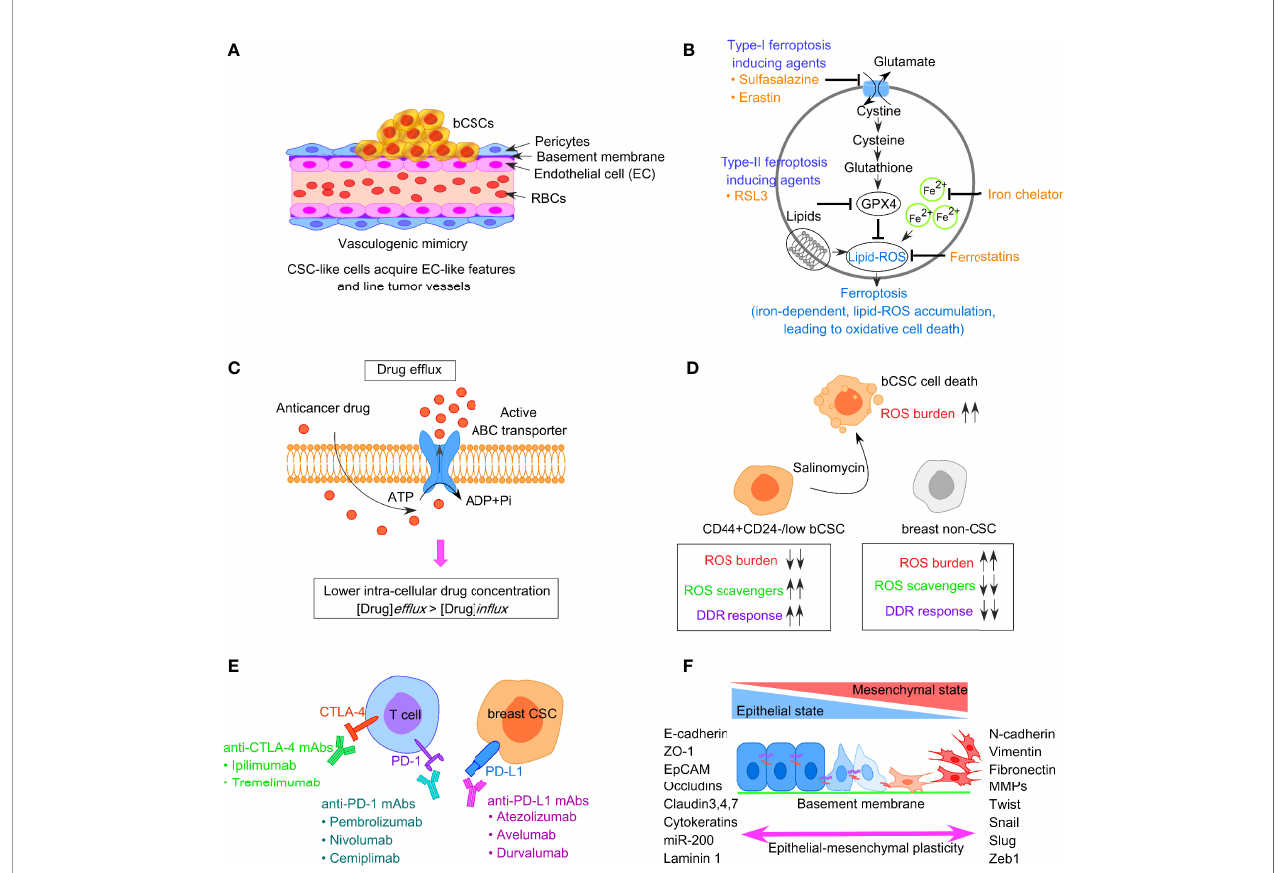
FIGURE 3 | Factors responsible for bCSC-mediated drug resistance against traditional anticancer therapeutics. (A) Concept of vasculogenic mimicry observed in breast CSCs leading to drug resistance. (B) Representative image of ferroptosis pathway involving generation of lipid-ROS in an iron-dependent manner, leading to oxidative cell death of tumor cells. (C) Increased drug ef fl ux due to enhanced expression of ABC transporters in bCSCs, resulting in lower intracellular chemotherapeutic drug concentration. (D) Low ROS burden and enhanced DNA damage repair in bCSCs. (E) Restoration of T-cell activity by targeting immune- checkpoint molecules like PD-1, PD-L1, and CTLA-4 to reverse CSC-mediated immune escape in breast cancer. (F) Epithelial-mesenchymal transition (EMT) plasticity indicating the gradual transition of cancer cells from epithelial state to mesenchymal state and the transcription factors associated with the